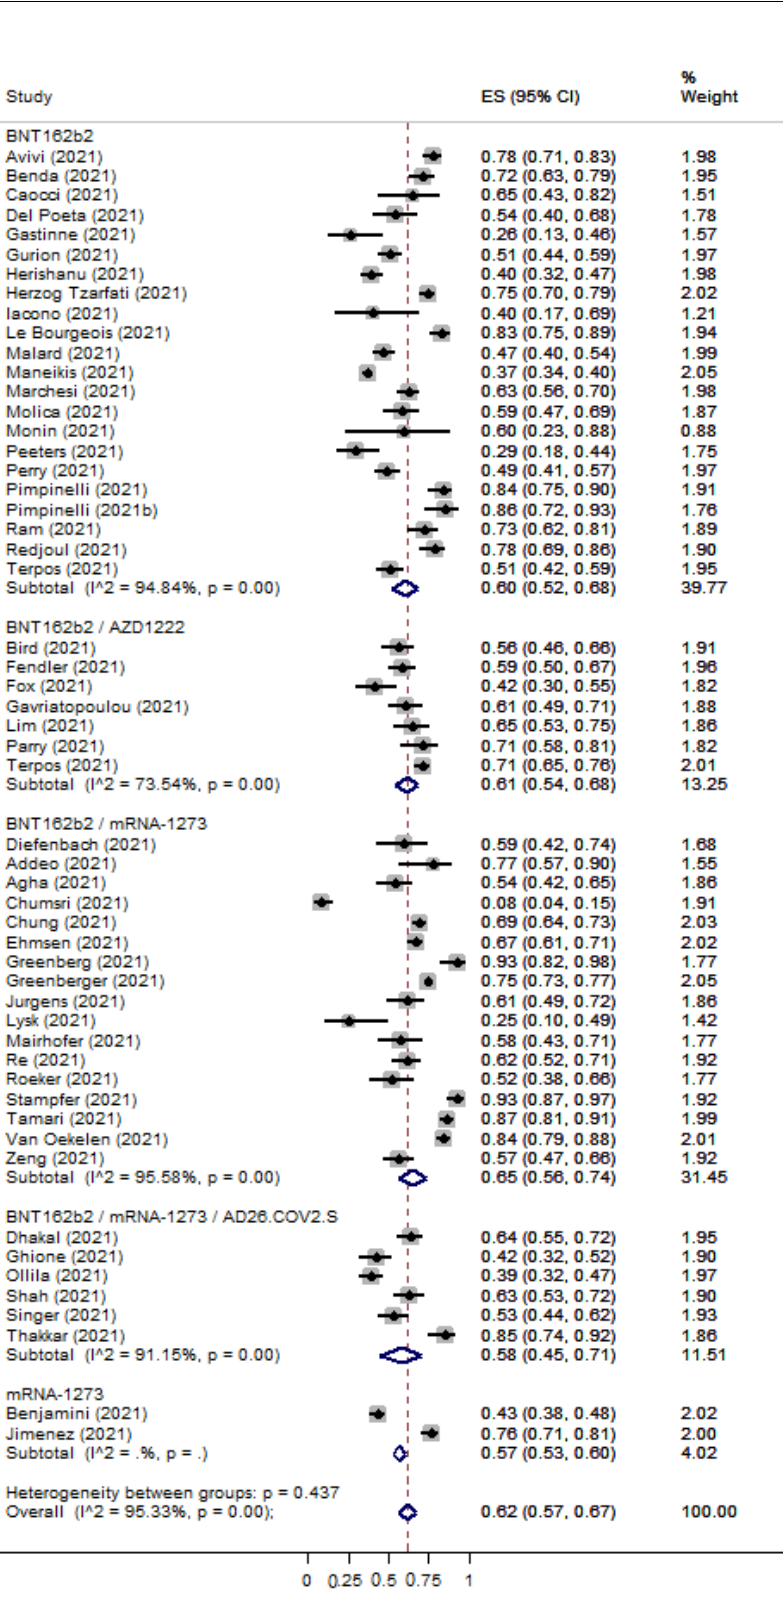
Figure 4. Pooled EffectSize (ES) for the immune seroconversion rates of patients with hematological malignancies after the second dose of COVID-19 vaccine. [7,8,15,17,18,20–25,28,29,32,35–40,42–50,52–61,63,66–71,74,75,80–82,84].